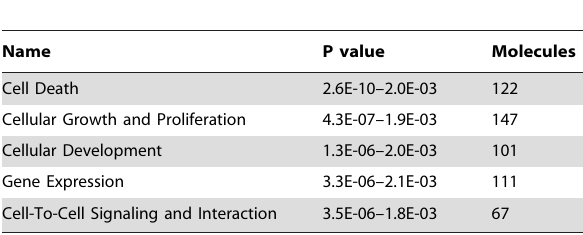
Table 1. Cellular and molecular functions of top 547 genes whose expression changed by allergen and reversed by GCs.